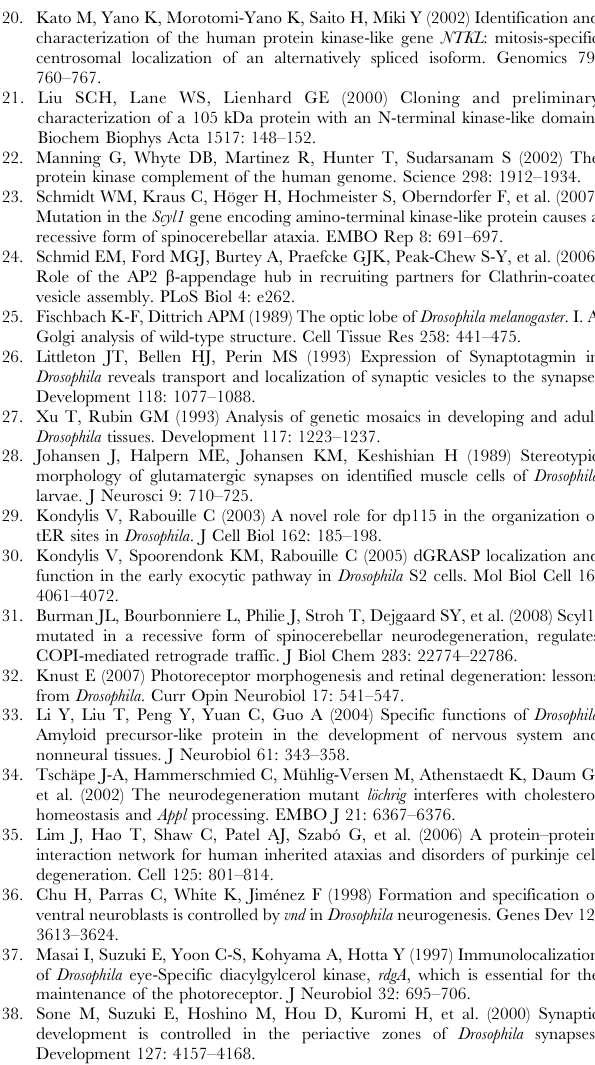
indicated region (blue arrow). (B) Such strong signals were